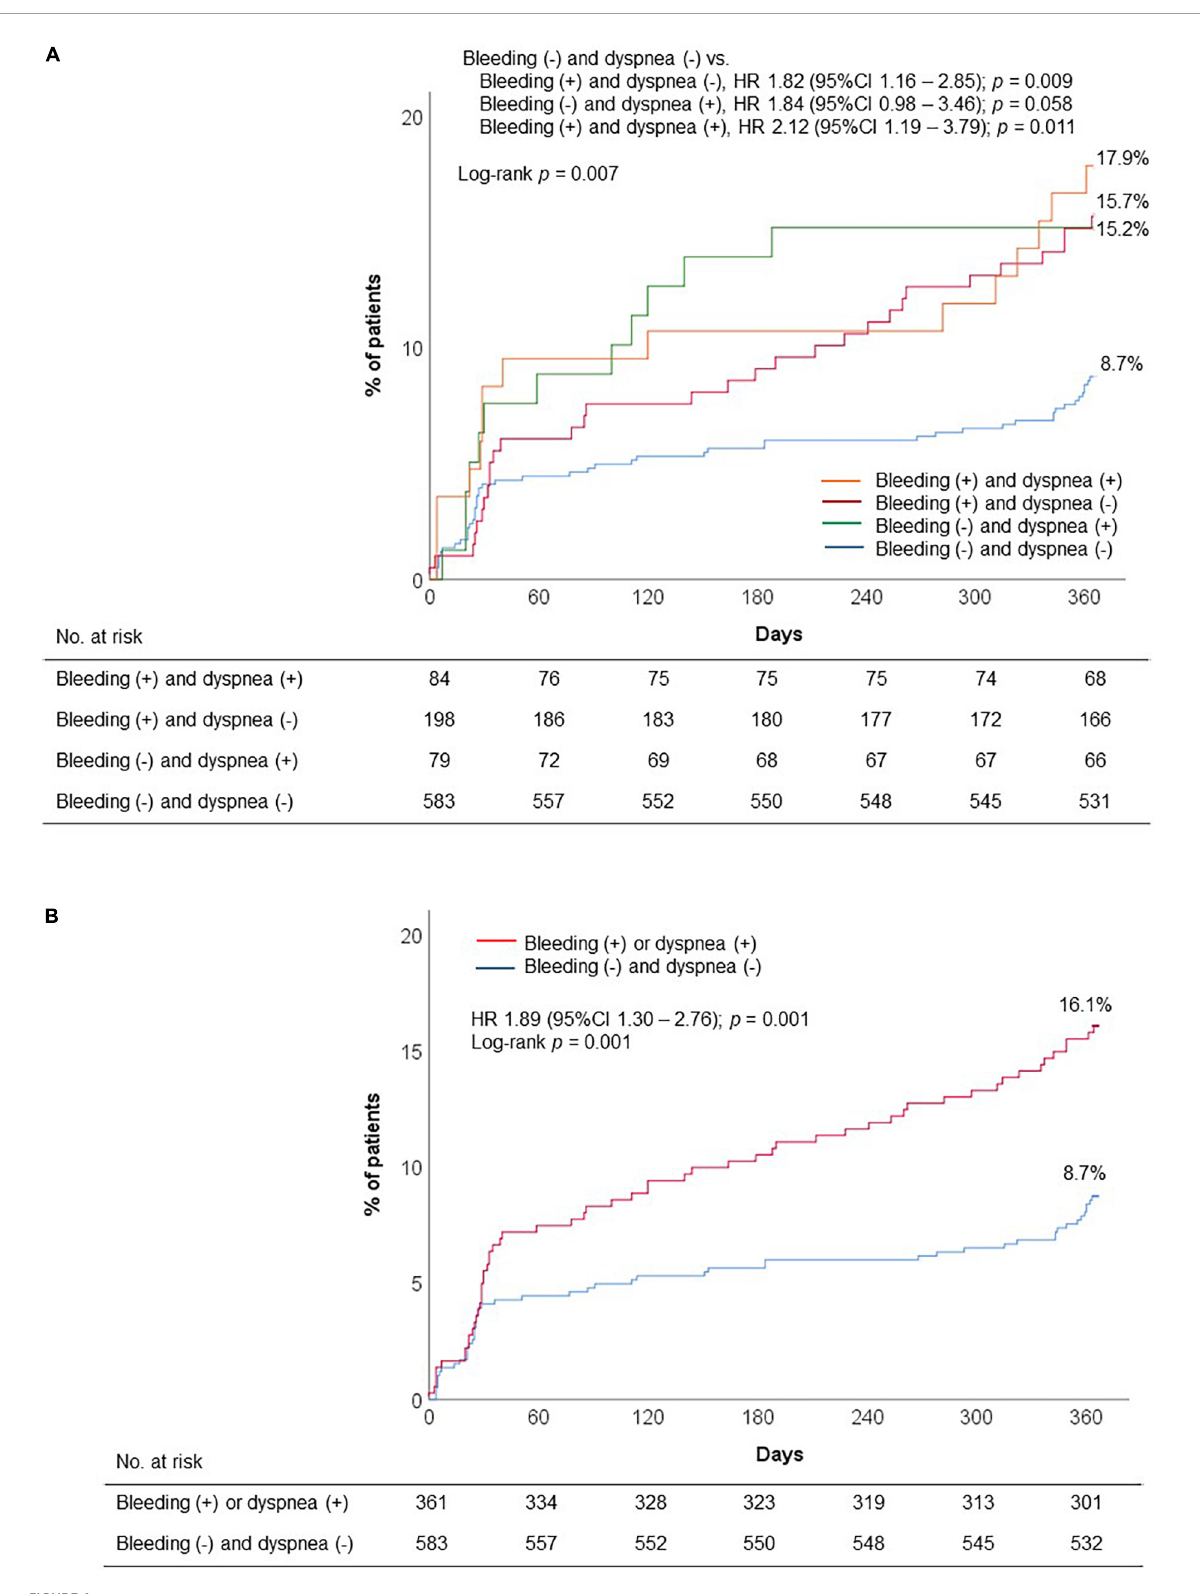
FIGURE4 Premature discontinuation of DAPT according to early occurrence of adverse events: (A) Four groups: Presence of bleeding or dyspnea; and (B) two groups: presence of bleeding or dyspnea. DAPT, dual antiplatelet therapy; HR, hazard ratio.